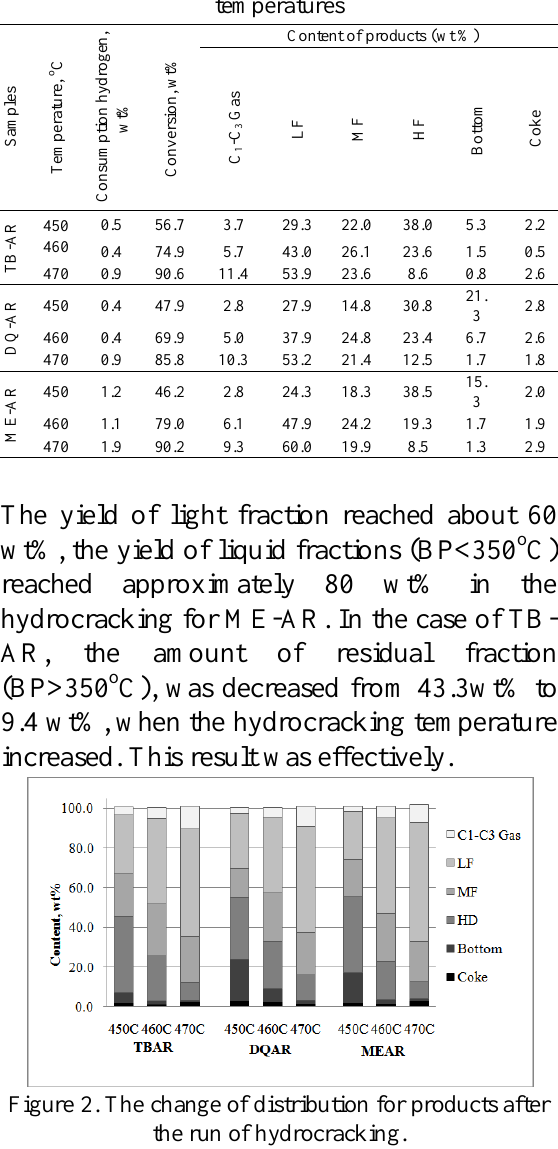
Figure 2. The change of distribution for products after the run of hydrocracking.